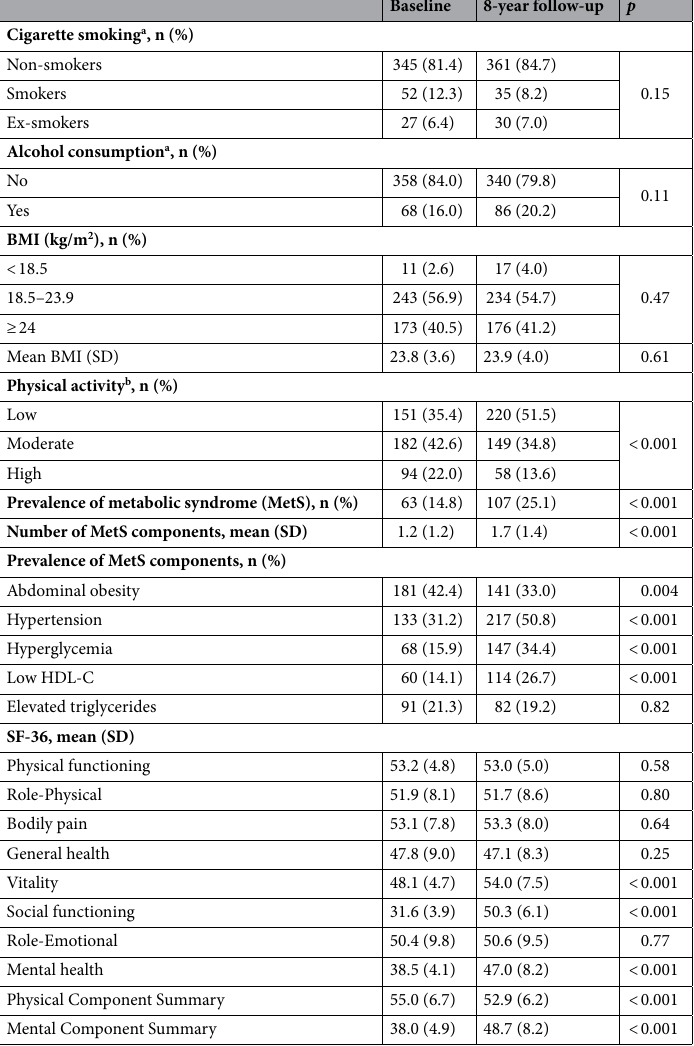
Sex differences of demographic characteristics were shown in Supplementary Table S1. Women had lower ratios of being married (83.3% vs. 90.7%) and being highly educated (university and above: 55.9 vs. 70.7%) than men. Women were less likely to have habits of cigarette smoking (3.6% vs. 24.9%) and alcohol consumption (6.3% vs. 29.9%). Women also had a lower mean BMI than men at both baseline (22.7 kg/m 2 vs. 25.3 kg/m 2 ) and follow-up (22.8 kg/m 2 vs. 25.5 kg/m 2 ). During the study period, there were 298 (69.8%) participants who never had MetS. 22 (5.2%) participants had an improved MetS status. 66 (15.5%) individuals were categorized as progressed MetS group. 41 (9.6%) subjects had persistent MetS. Women had a higher ratio of never had MetS (77.9% vs. 58.1%), and lower ratios of progressed and persistent MetS status (13.4% vs. 18.4% and 5.9% vs. 14.9%, respectively). There were no significant sex differences in mean age at baseline, change in BMI, physical activity